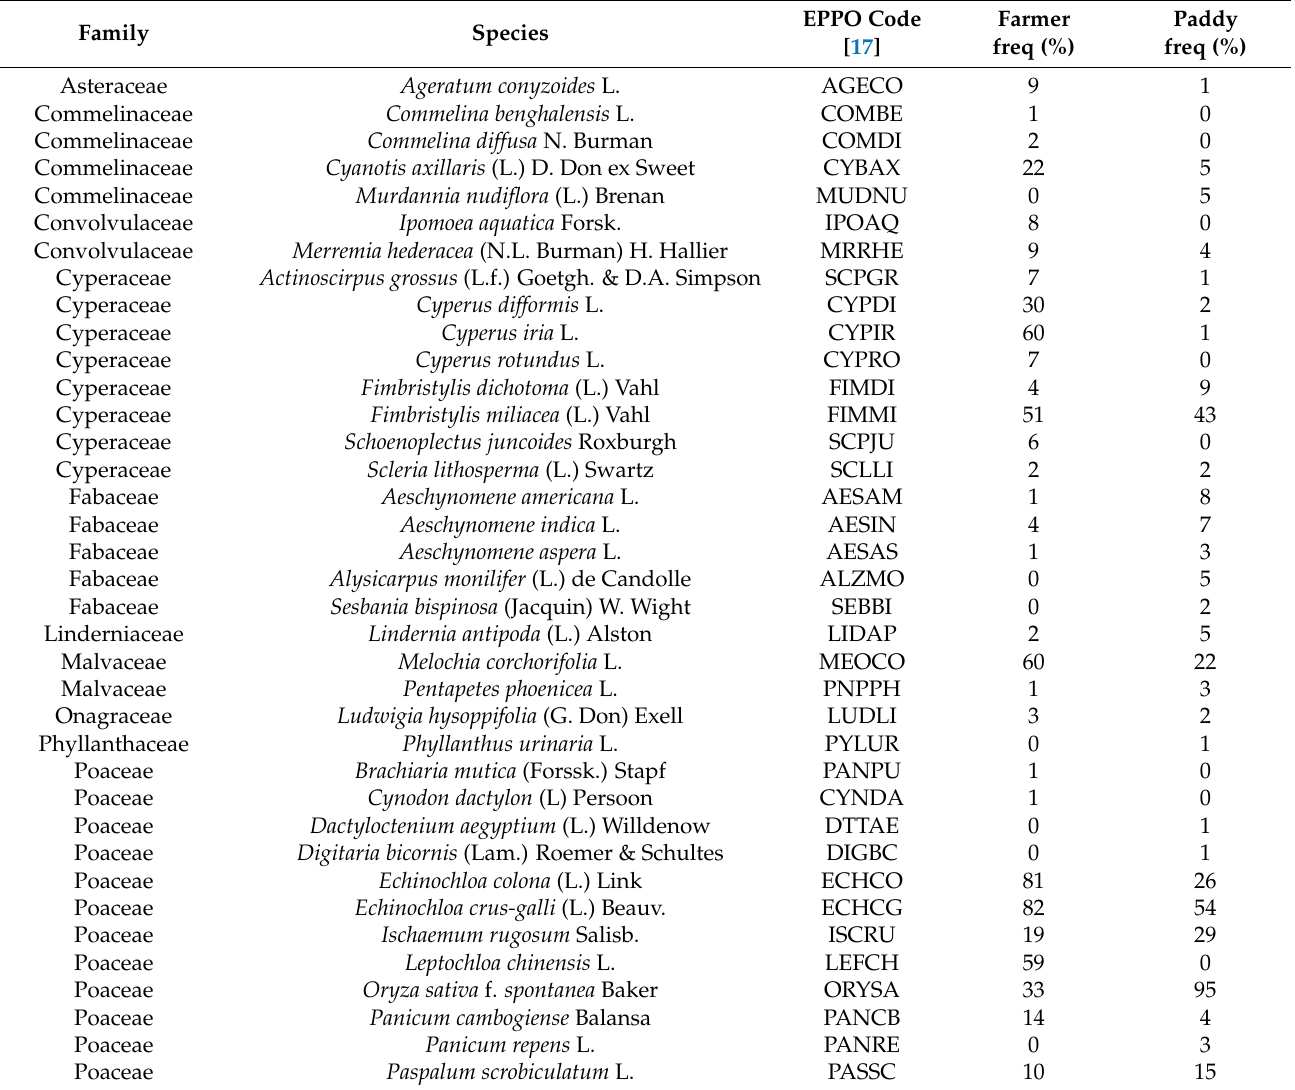
Table 4. Weed species identified by farmers and recorded in harvested paddy in the survey.